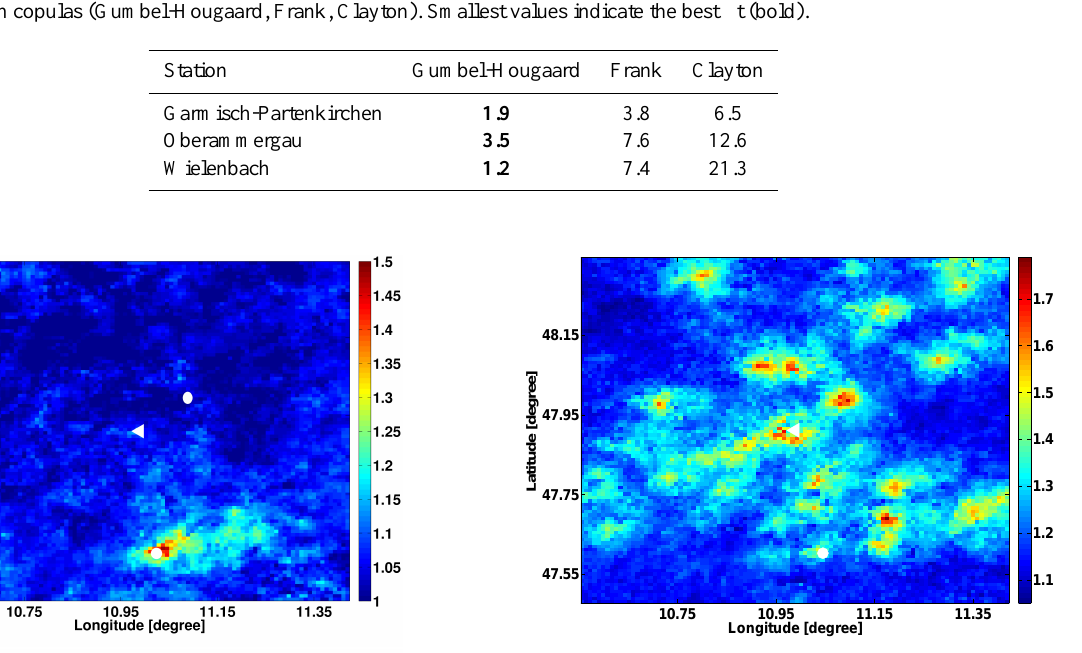
Fig. 7: Maximum Theta map derived from all gauge sta- tions in the domain.